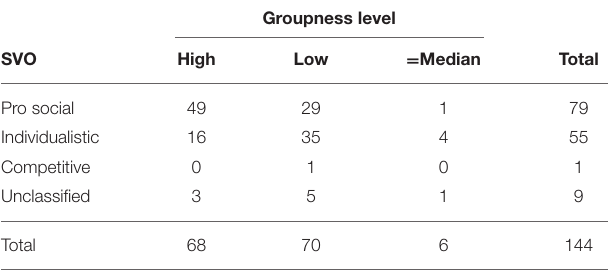
TABLE 3 | Distribution of participants accross SVO and groupness